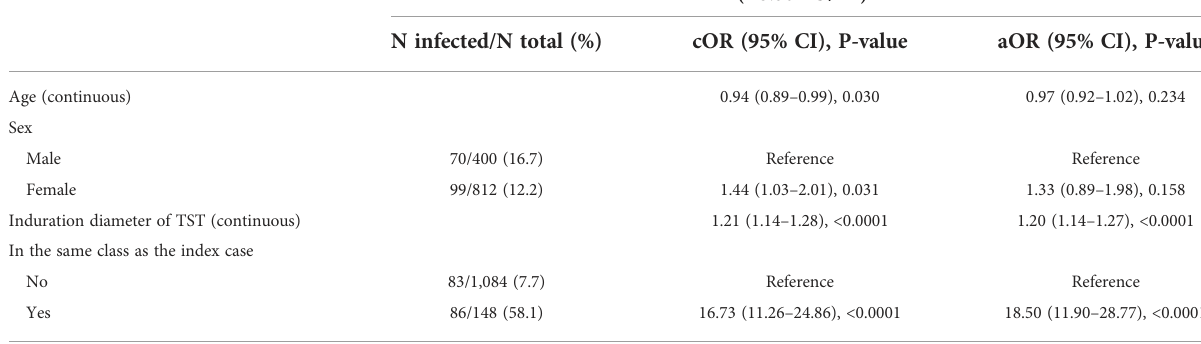
TABLE 2 Logistic regression analysis of the risk of QuantiFERON-TB gold in-tube positivity.